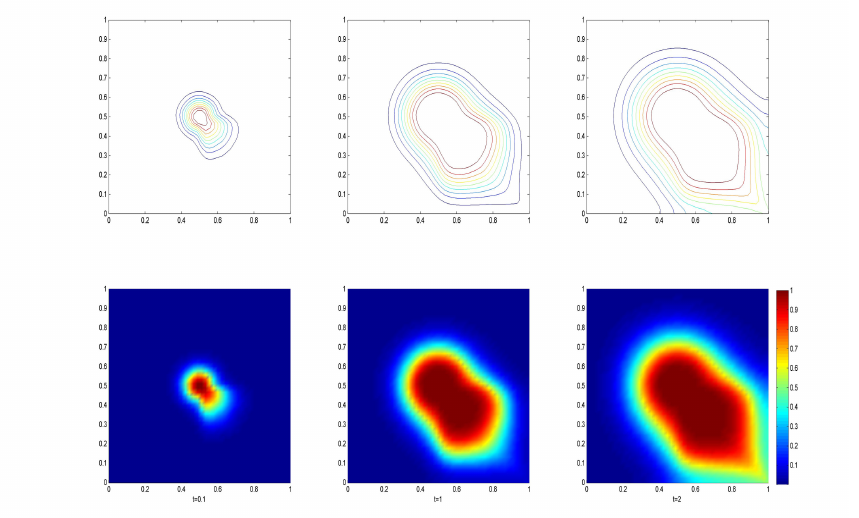
Figure 5. Contours and graphs of concentration in random permeability